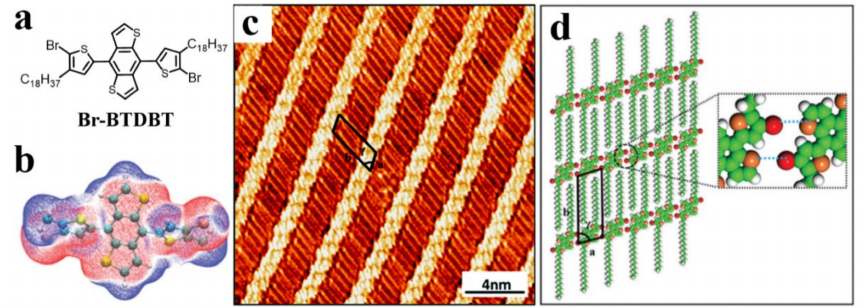
Figure 8. ( a ) Chemical structure of Br-BTDBT. ( b ) Calculated 3D ESP map of Br-BTDBT core, note that the alkyl side chains are replaced by the methyl groups for brevity. ( c ) High-resolution STM image of the adlayer formed by Br-DTBDT at the 1-phenyloctane / HOPG interface. ( d ) Proposed molecular model of the linear structure. Inset shows the intermolecular interactions. Reproduced from [80] with permission from the Royal Society of